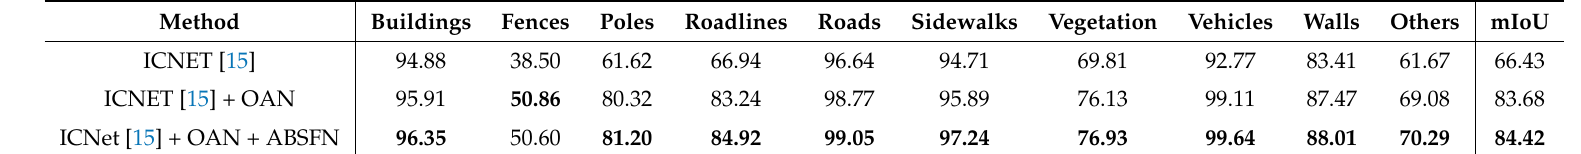
Table 1. Comparison on CARLA dataset. The bold fonts indicate the best results.